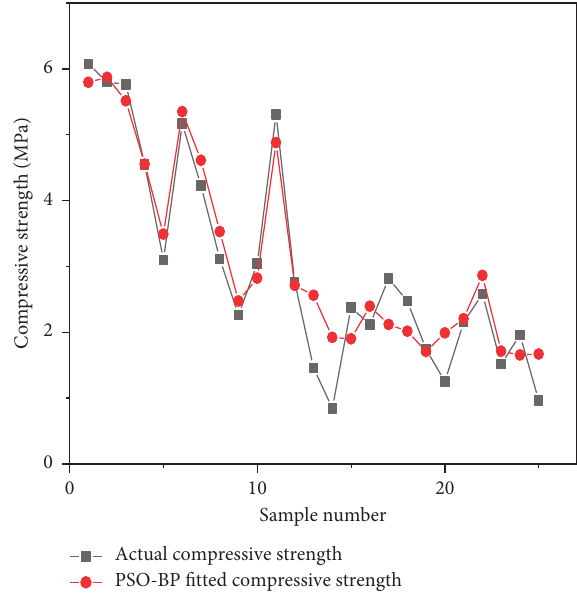
Figure 11: PSO-BP model fitting effect